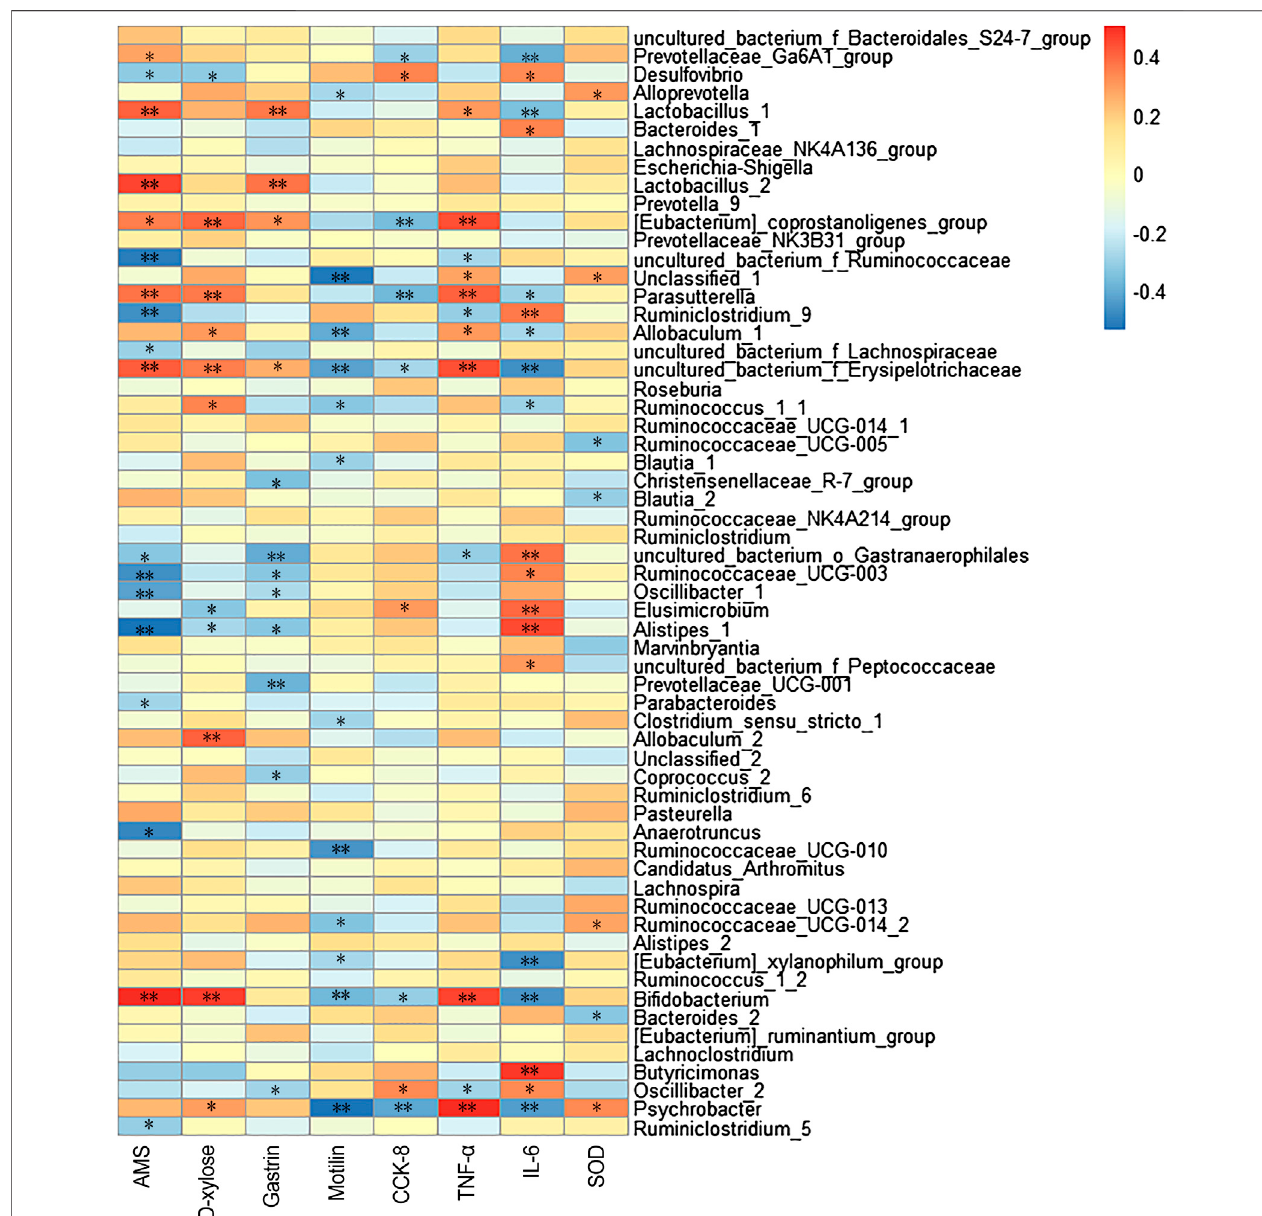
FIGURE 4 | Heatmap of Spearman ’ s correlation between gut microbiota (the relative abundances of top 60 genus) and spleen de fi ciency related indexes. The colors range from blue (negative correlation) to red (positive correlation). Signi fi cant correlations are noted by * p < 0.05 and ** p < 0.01.